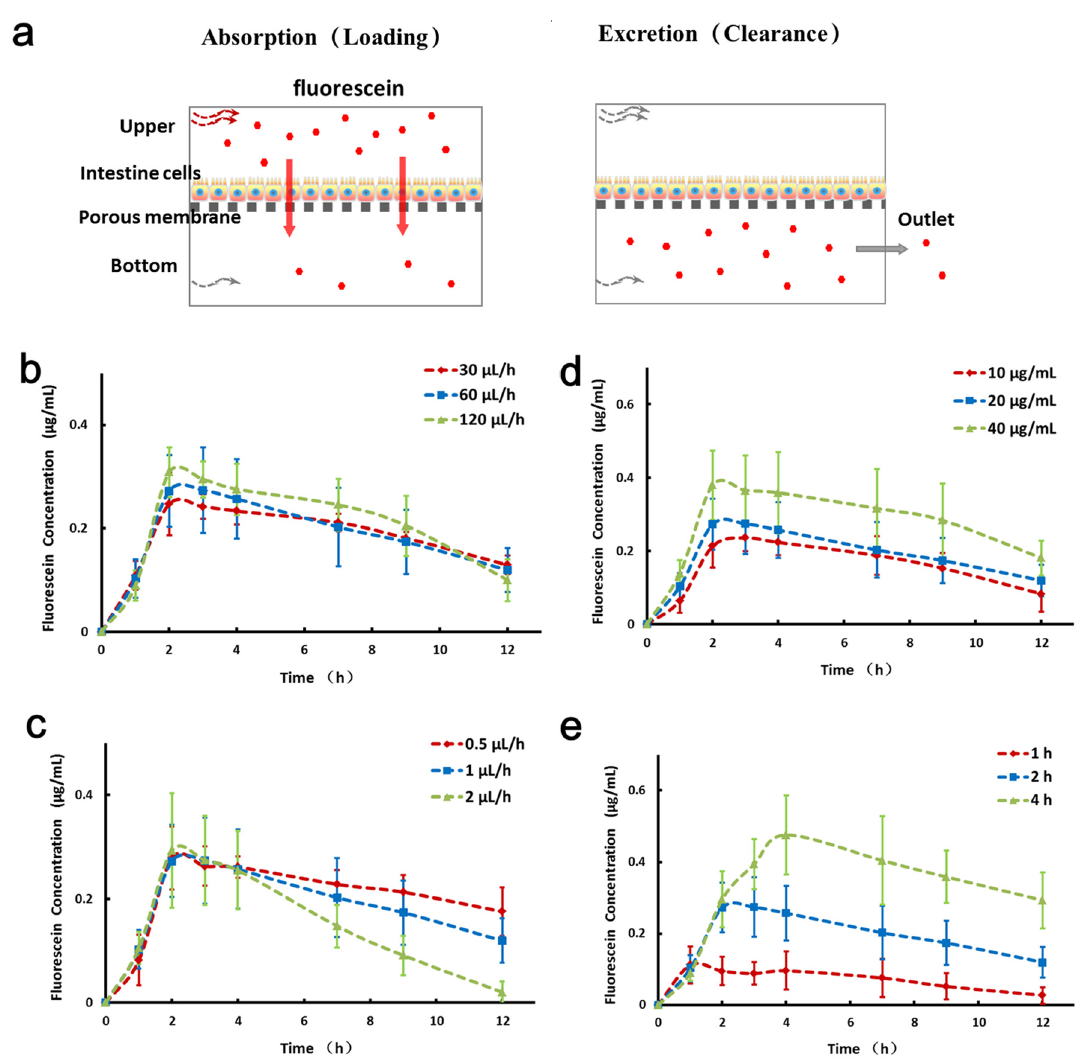
Figure 5. Simulation of dynamic drug absorption and excretion profiles using fluorescein on a microfluidic system. ( a ) Schematic drawing for the administration of fluorescein into the upper channel of device. The control parameters include flow rate, fluorescein concentration, and administration time. ( b ) Quantification of fluorescein concentration di ff used over the bottom channel by varying the flow rate (30, 60, 120 µ L / h) in the upper channel at di ff erent time points. The fluorescein concentration (20 µ g / mL), administration time (2 h), and flow rate in the bottom channel (1 µ L / h) are constant. ( c ) Quantified analysis of fluorescein concentration with di ff erent flow rates (0.5, 1, 2 µ L / h) in the bottom channel. The administration time (2 h), fluorescein concentration (20 µ g / mL), and flow rate in the upper channel (60 µ L / h) are constant. ( d ) Varying the fluorescein concentrations (10, 20, 40 µ g / mL) with fixed administration time (2 h) and flow rates in the upper channel (60 µ L / h) and bottom channel (1 µ L / h). ( e ) Varying administration time (1, 2, 4 h) of fluorescein administration with fixed concentration and flow rates.